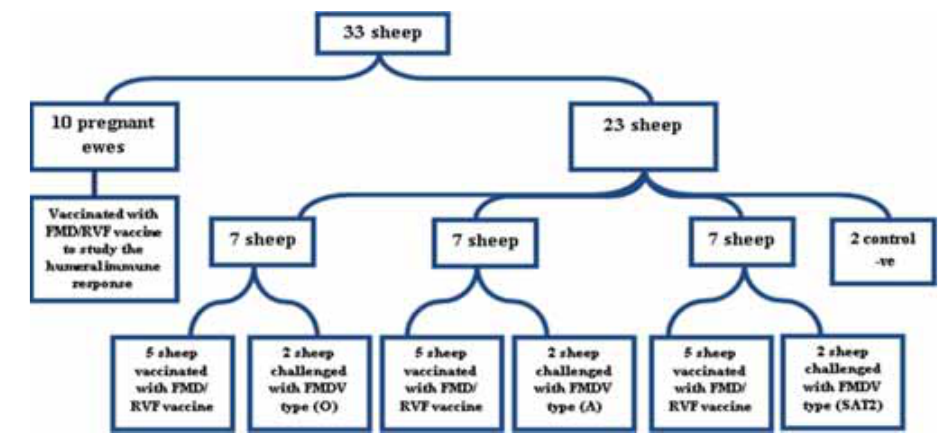
Figure-1: Classification of experimental sheep. *The combined vaccine was inoculated S/C at a dose of 1 ml/animal inoculated. Each 1 ml dose contain 10 9 of the Foot and mouth disease virus serotype A, O , SAT2 and 10 8.5 TCID Rift Valley Fever. **The pregnant ewe were vaccinated with at 2-3 months before